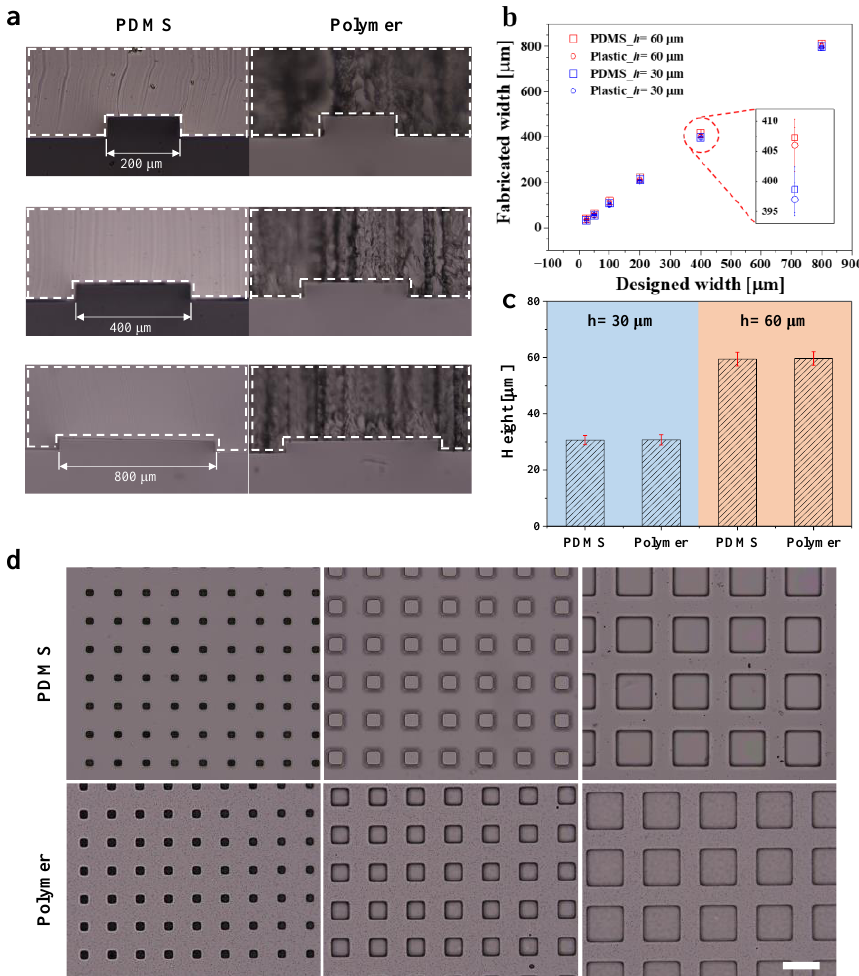
Figure 2. Dimension comparison of polymer and PDMS devices. ( a ) Bright-field images of cross- sections of PDMS channels (left) and polymer channels (right). Channel widths were 200, 400, and 800 μ m from the top, and height was 60 μ m. ( b , c ) Comparison of ( b ) width and ( c ) height in each channel. ( d ) Bright-field images of the square-shaped microchamber array. Scale bar represents 200 μ m.